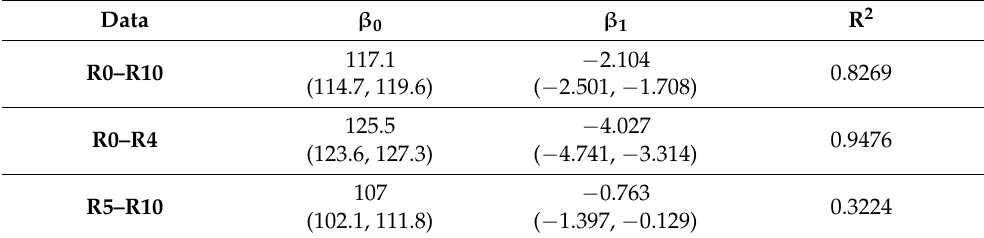
Table 5. Summary of results obtained from the linear fitting (Y = β 0 + β 1 ·RN) of the experimental data. The coefficients β 0 and β 1 are accompanied with their 95% confidence bounds.